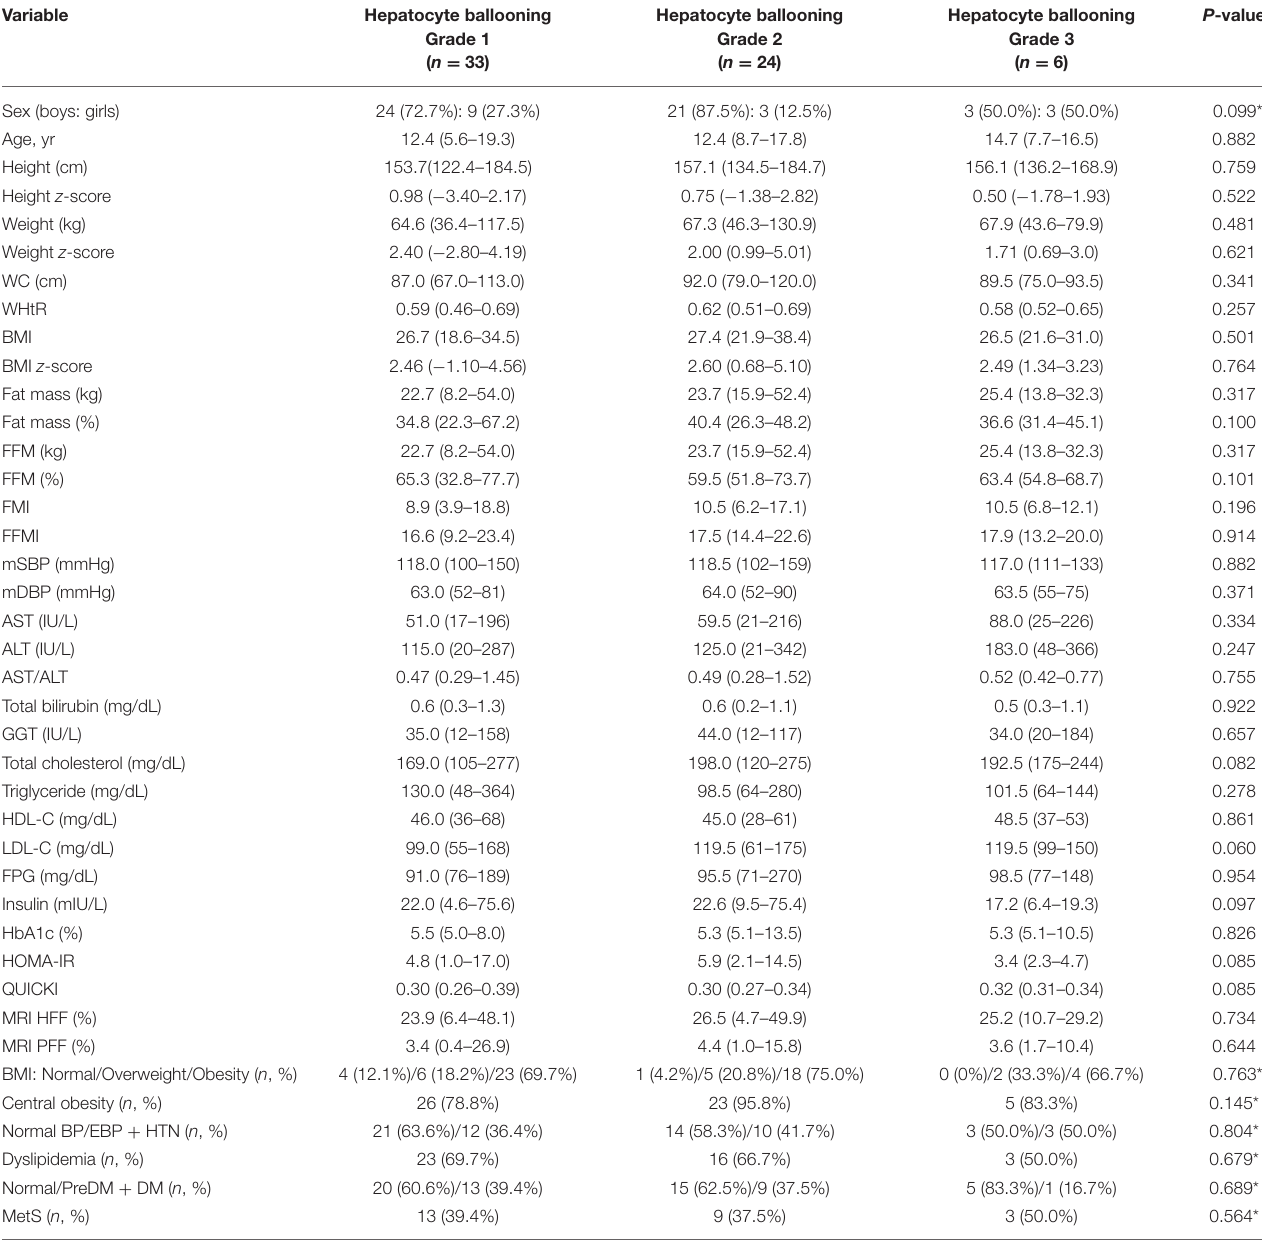
TABLE 4 | Comparison of demographic, anthropometric, laboratory, and magnetic resonance imaging-measured fat fraction findings of 63 children with non-alcoholic fatty liver disease by liver histologic ballooning degeneration grade.